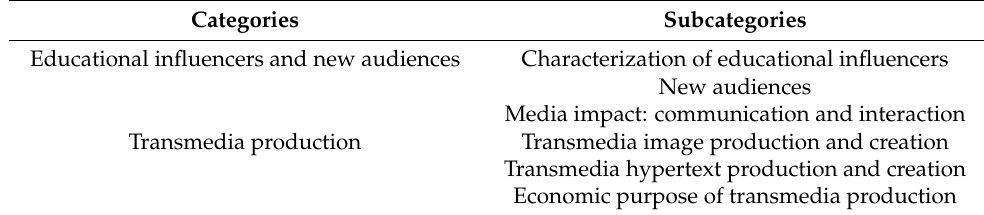
Table 1. Categories and